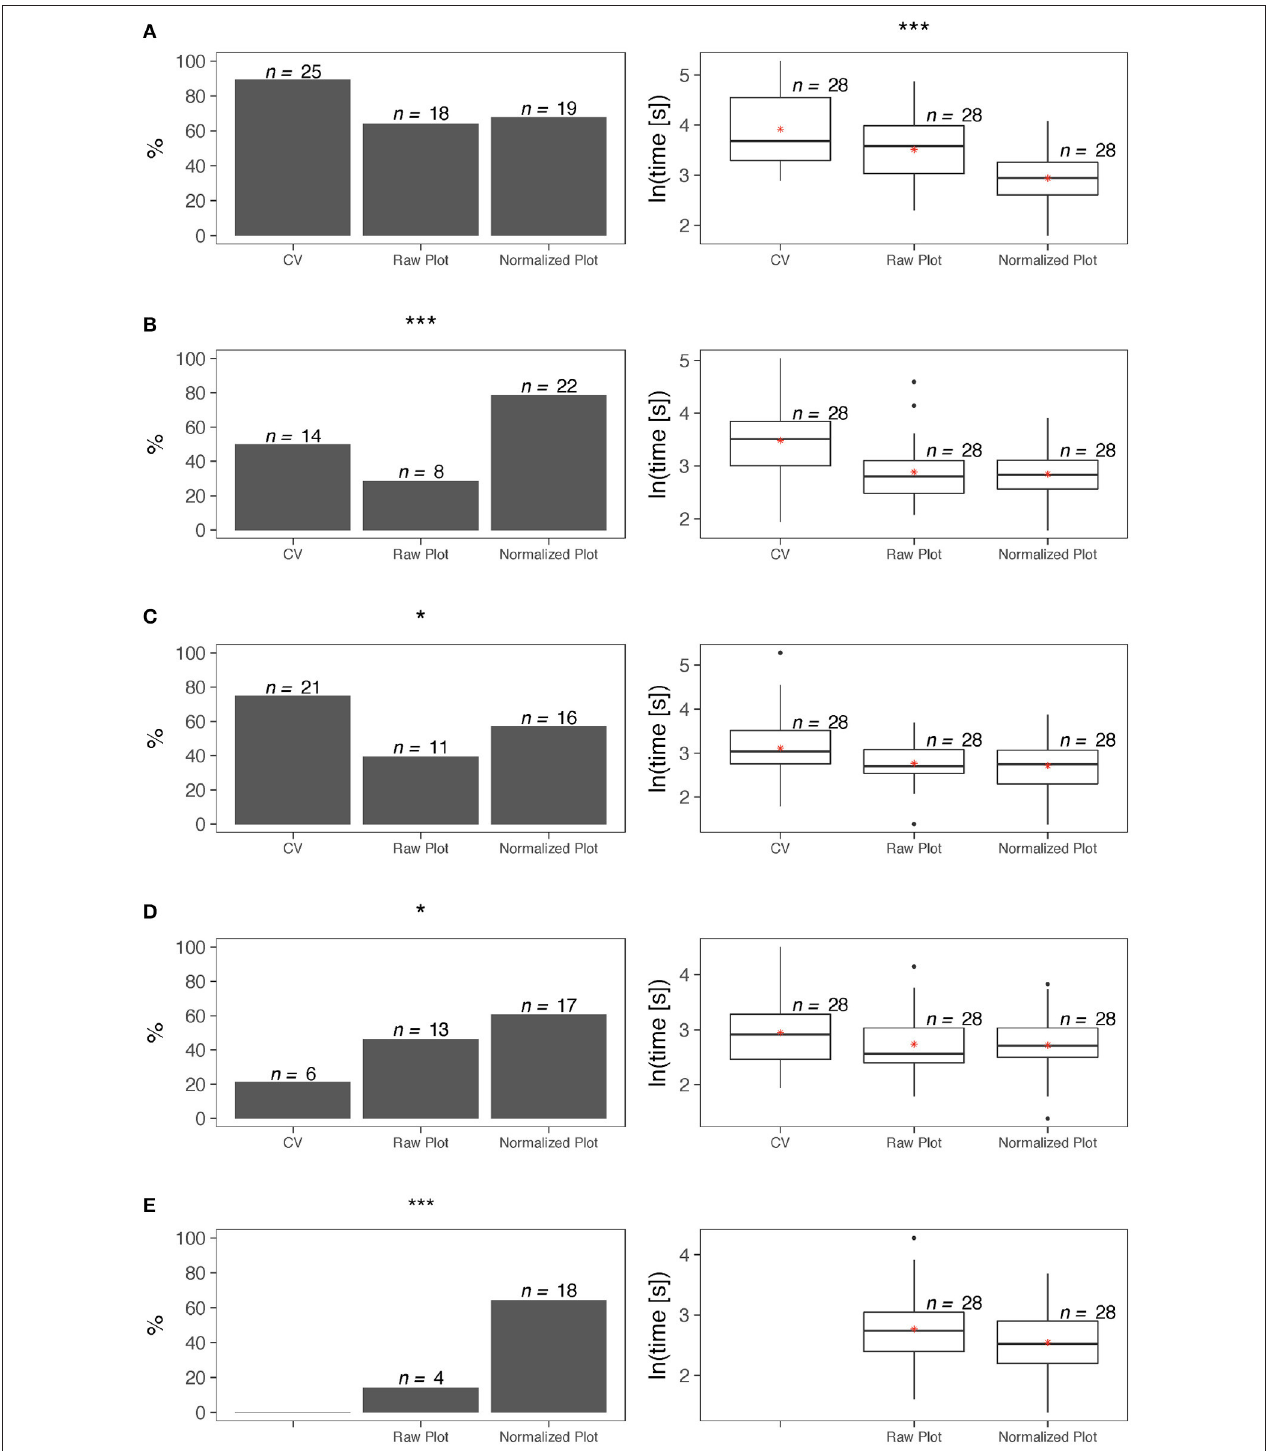
FIGURE 6 | Survey statistics for the plot form of SP–left column depicts accuracy results, while right column depicts completion time results. (A) Overall citation record. (B) Citation impact of recent publications. (C) Overall competitiveness of publications. (D) Overall funding record. (E) Effect of funding on citation impact. Levels of significance were set at * α = 0.05, ** α = 0.01, and *** α =